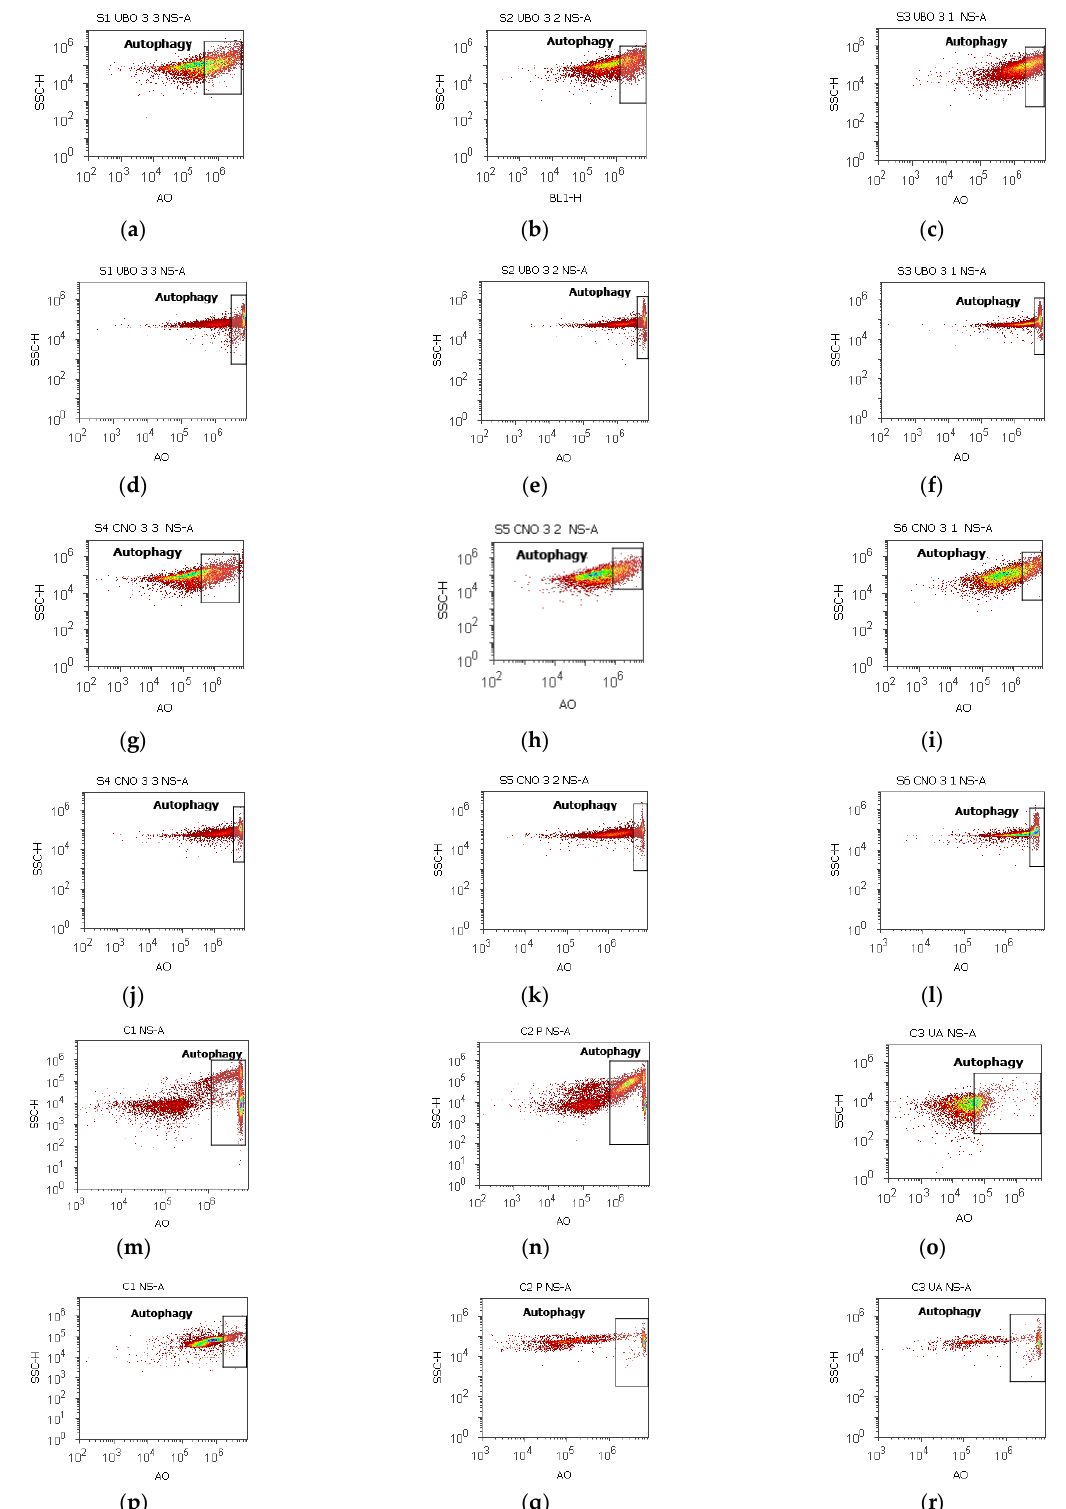
Figure 8. Autophagy in blood cells and CLS-354 tumor cells after 24 h exposure to different concen- trations [3:3; 3:2; 3:1] of U. barbata extract in canola oil (UBO) ( a – f ) and canola oil (CNO) ( g – l ) com- pared to C1, C2P, and C3UA controls ( m – r ). C1 — 1% DMSO (negative control), C2P — 5% Poloxamer 407 (positive control), C3UA — usnic acid (positive control), A — Autophagy, NS — Nuclear shrink- age, [3:3; 3:2; 3:1] — culture medium/sample ratio ( v/v